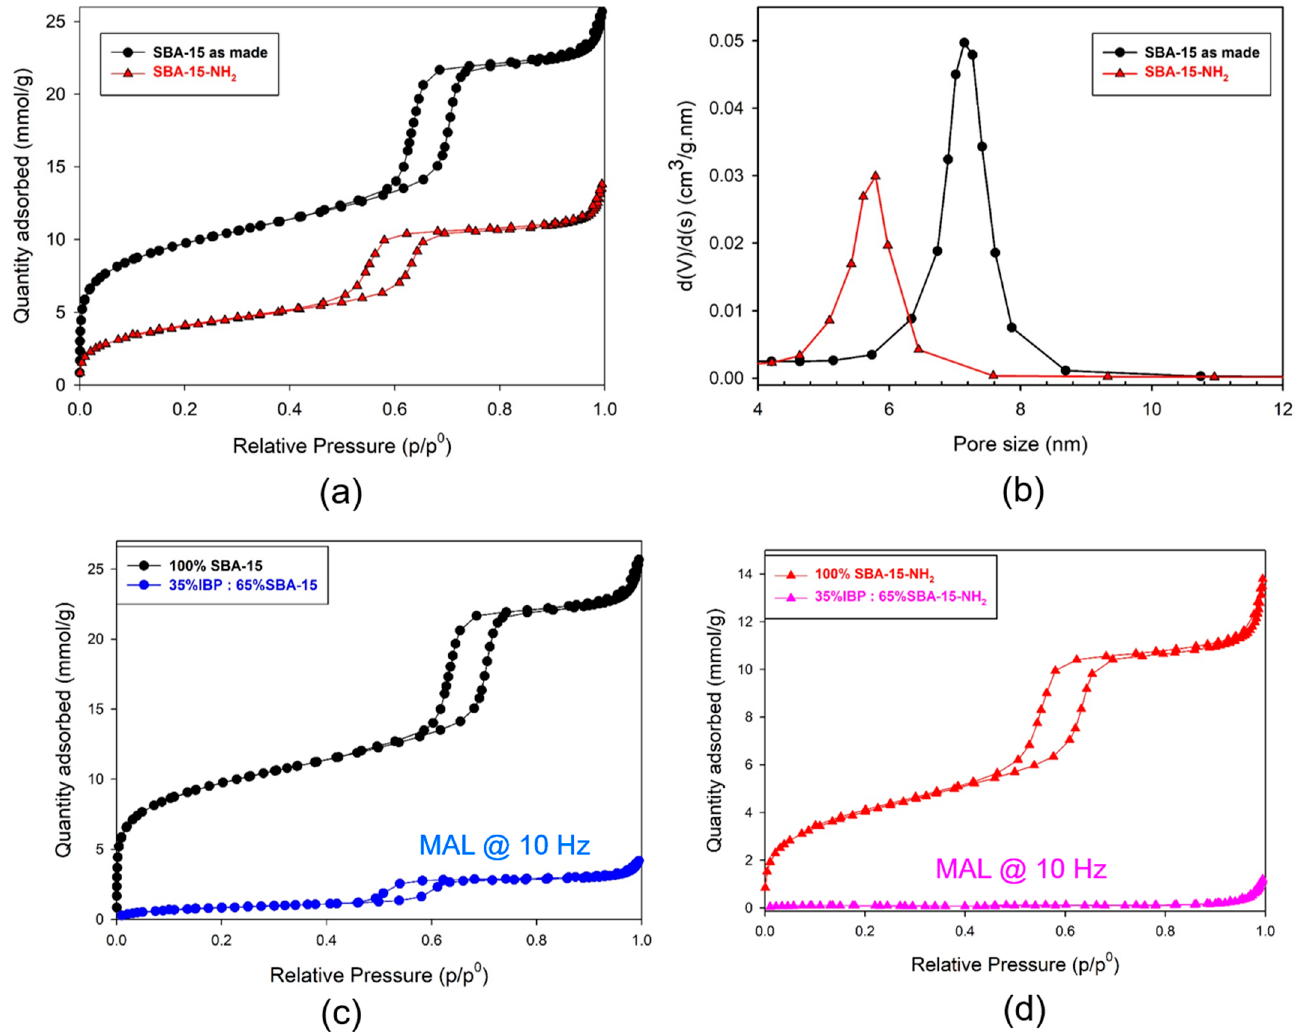
Figure 1. Characterization of mesoporous silica; ( a ) N 2 adsorption isotherms for SBA-15 and SBA-15-NH 2 ; ( b ) pore size distribution of SBA-15-NH 2 as given by the BJH method; ( c ) comparison between N 2 adsorption isotherms for SBA-15 and composites loaded by MAL at 10 Hz; ( d ) comparison between N 2 adsorption isotherms for SBA-15-NH 2 and composites loaded by MAL at 10 Hz .